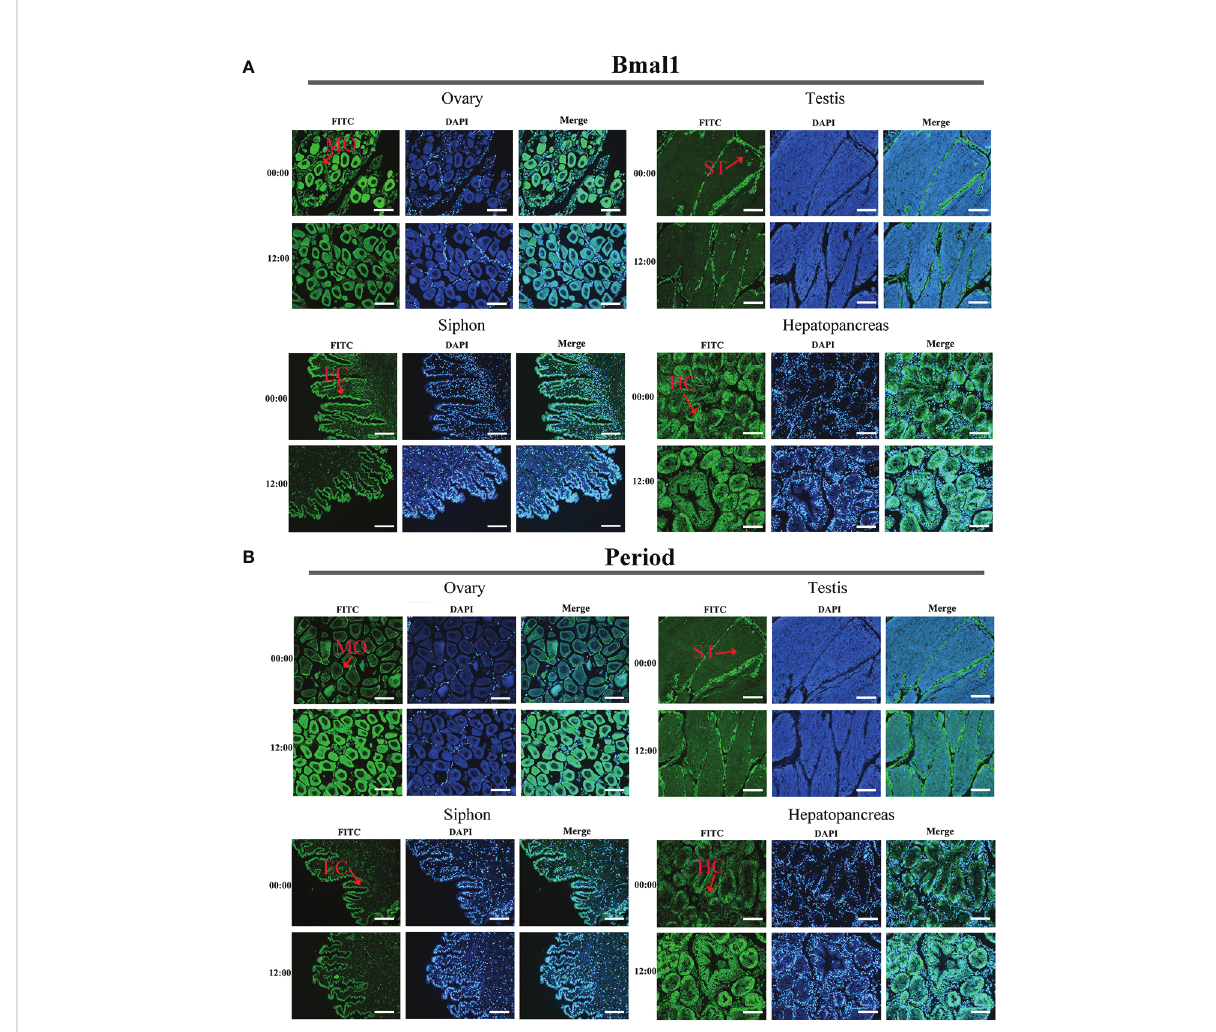
FIGURE 5 Distribution of Bmal1 and Period proteins used immuno fl uorescence staining in four tissues. (A) Distribution of Bmal1 protein. (B) Distribution of Period protein. MO, Mature oocytes; ST, Spermatid; HC, Hepatocytes; CC, Ciliated column cells; EC, Epithelial cell. Scale bars were 100 m